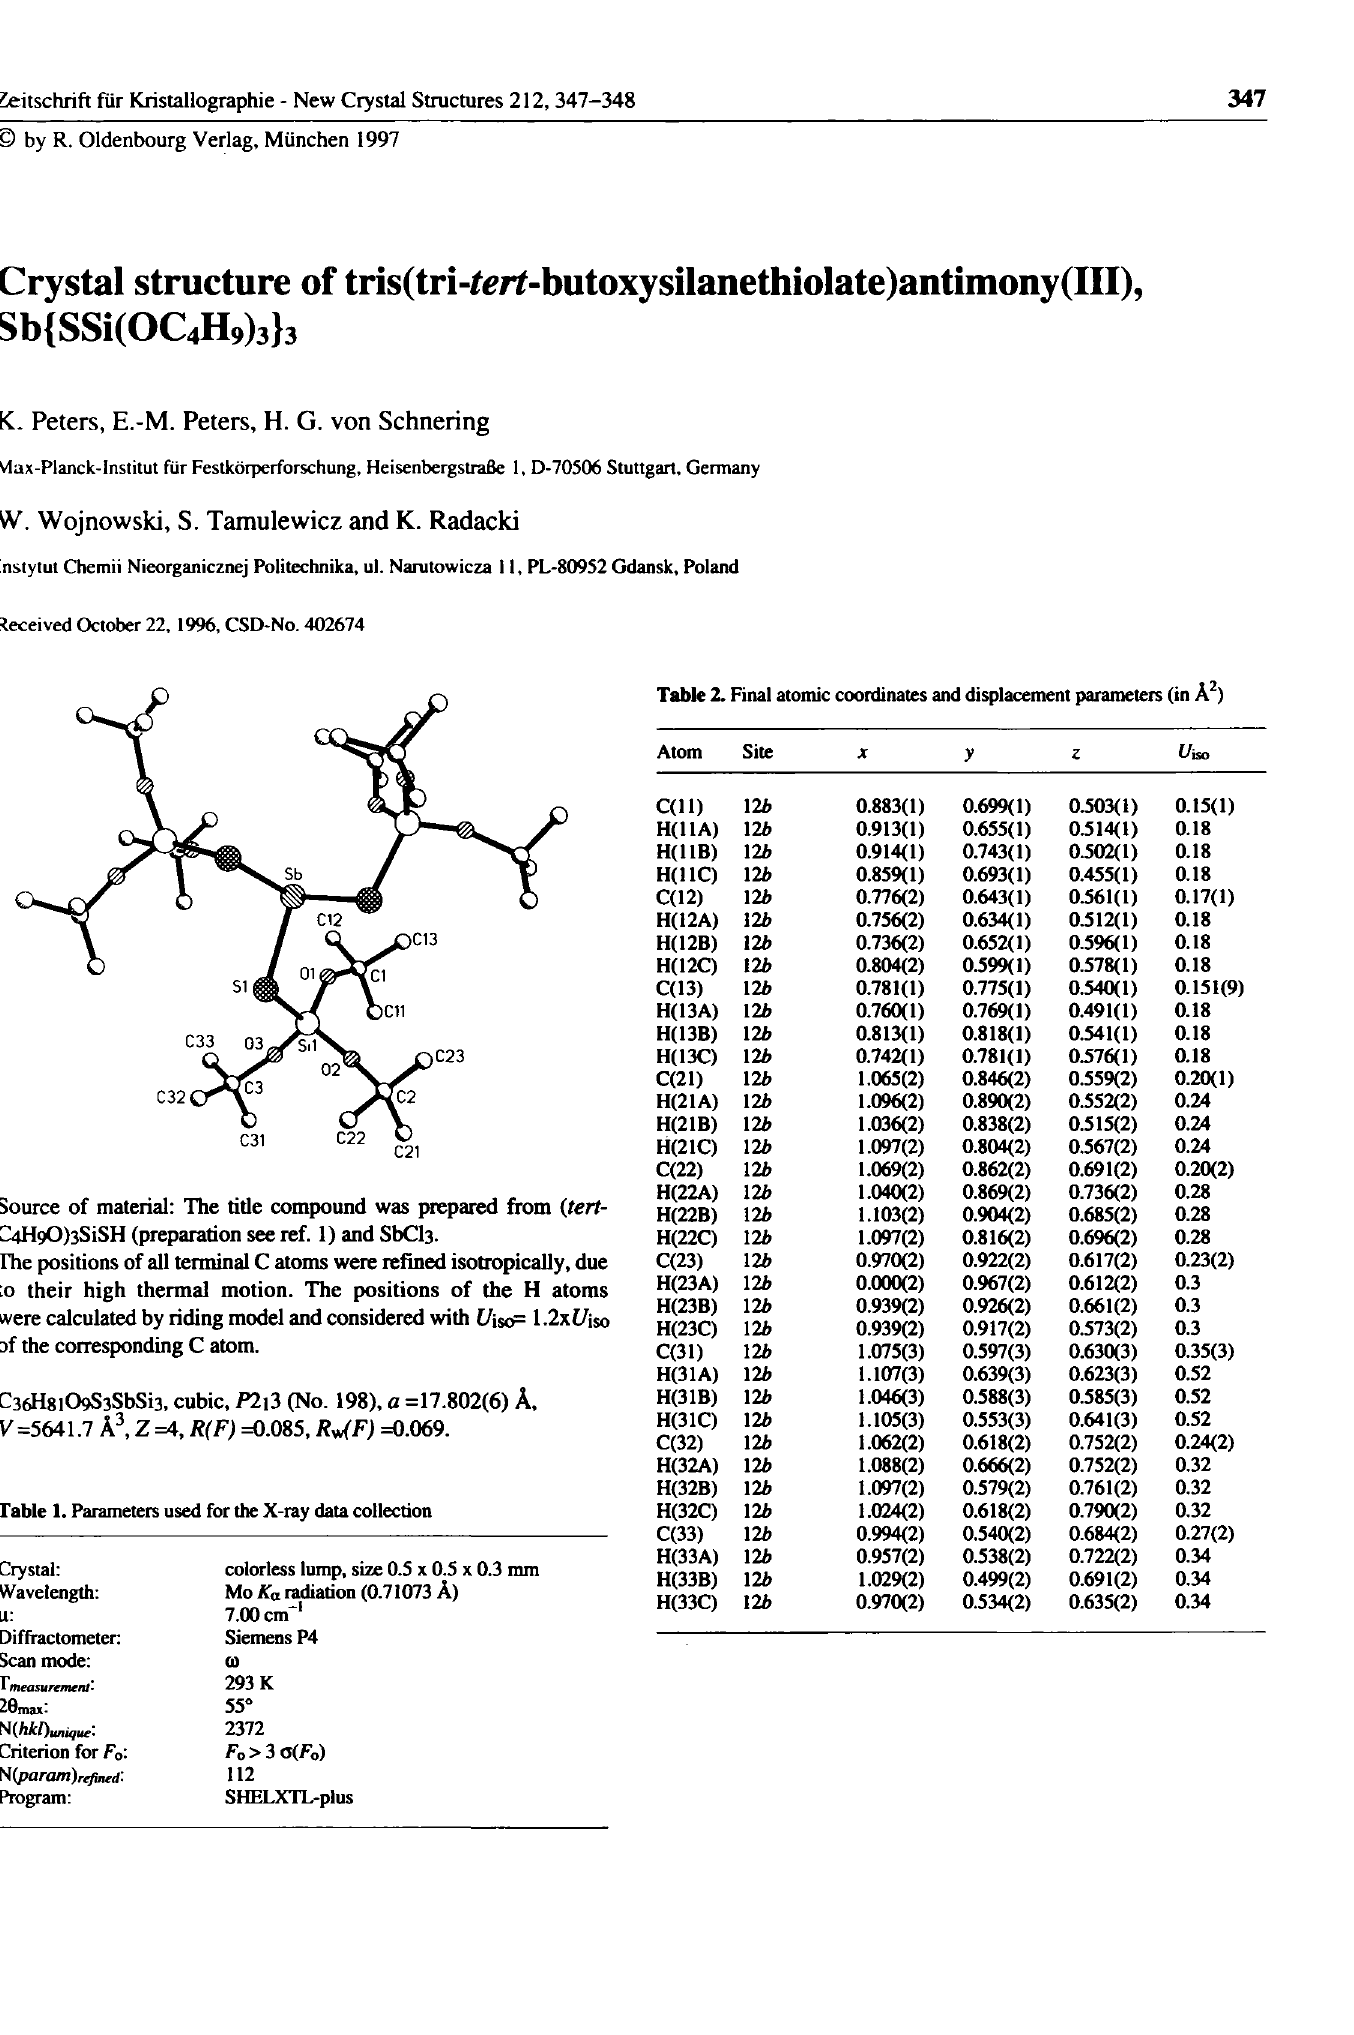
Table 1. Parameters used for the X-ray data collection